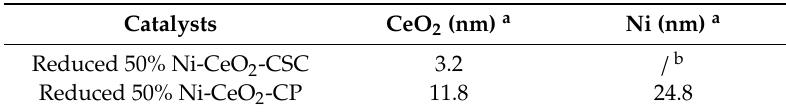
Table 2. Cristal size of the reduced 50% Ni-CeO 2